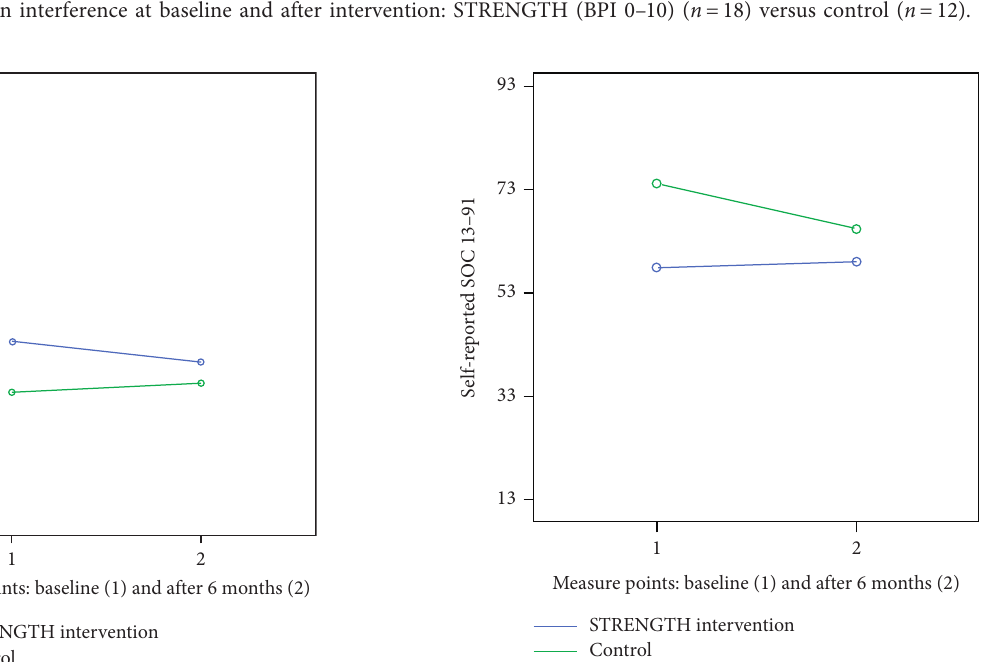
Figure 3: Reported level of depression (GDS) at baseline and after intervention: STRENGTH ( n � 18) versus control ( n � 12).